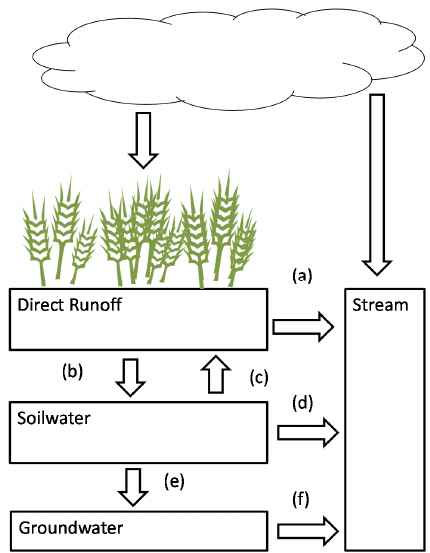
Fig. 2. Simple hydrologic response unit comprised of three buckets representing direct runoff, soil water and groundwater. The arrow labels (a) – (f) identify different fluxes and can be linked to the flow partitioning matrix shown in Table 2. (a) represents direct runoff to the river; (b) is infiltration from the direct runoff to soil water bucket; (c) represents saturation excess return flow from the quick bucket to the soil surface, while (d) is flow from the soil water bucket to the river. Flux (e) is from the soil water to groundwater bucket, while flux (f) represents water flow from the groundwater bucket to the river.